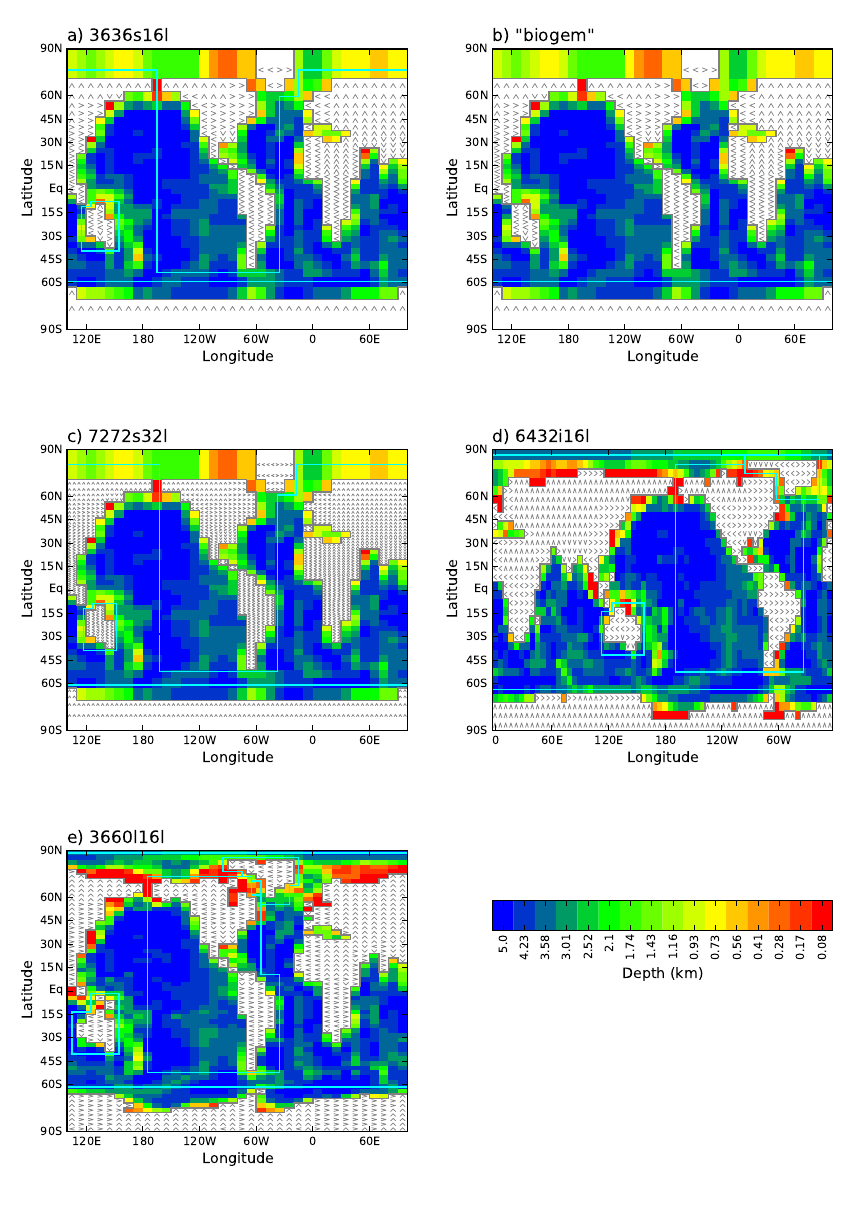
Fig. 1. Model ocean bathymetry at different resolution, for each configuration. The arrows indicate direction of runoff. The paths around islands used for the computation of the barotropic streamfunction are superimposed in cyan.